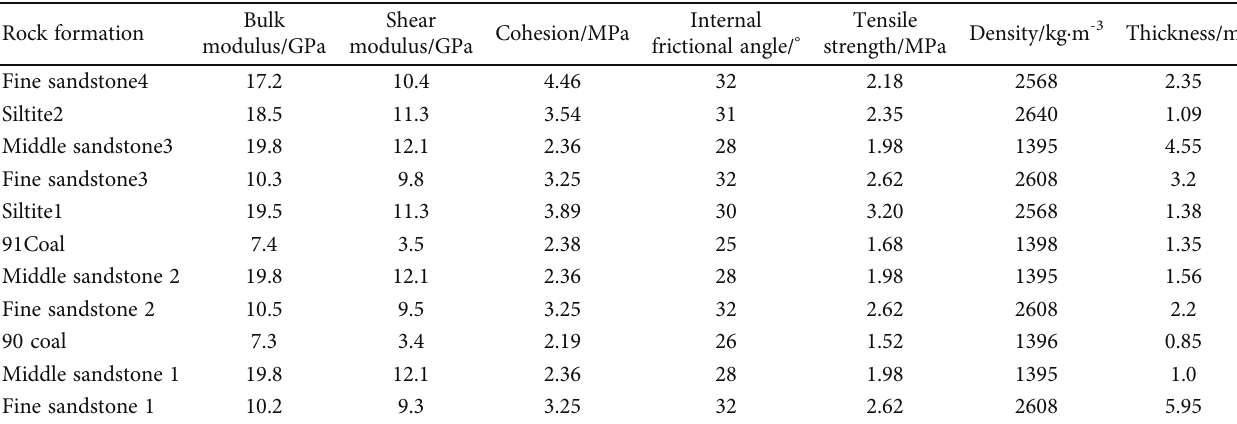
Figure 14: Optimized roadway section support Table 2: Mechanical parameters and thickness of surrounding rock.